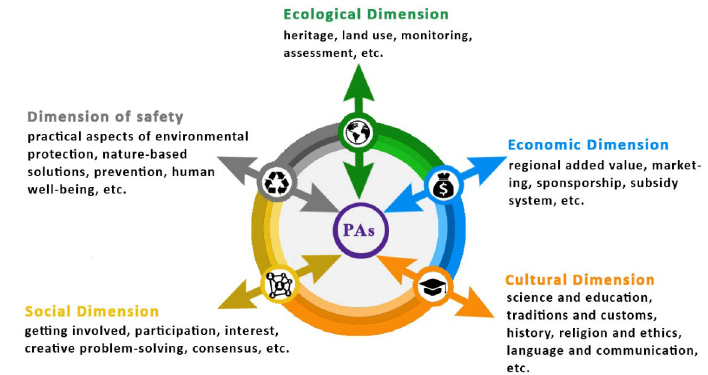
Figure 4. Five Dimensions Model of Sustainable Development (source: Authors’ own Table 1. An overview of fields of activity in each phase of the life-cycle of protected areas according to IPAM toolbox